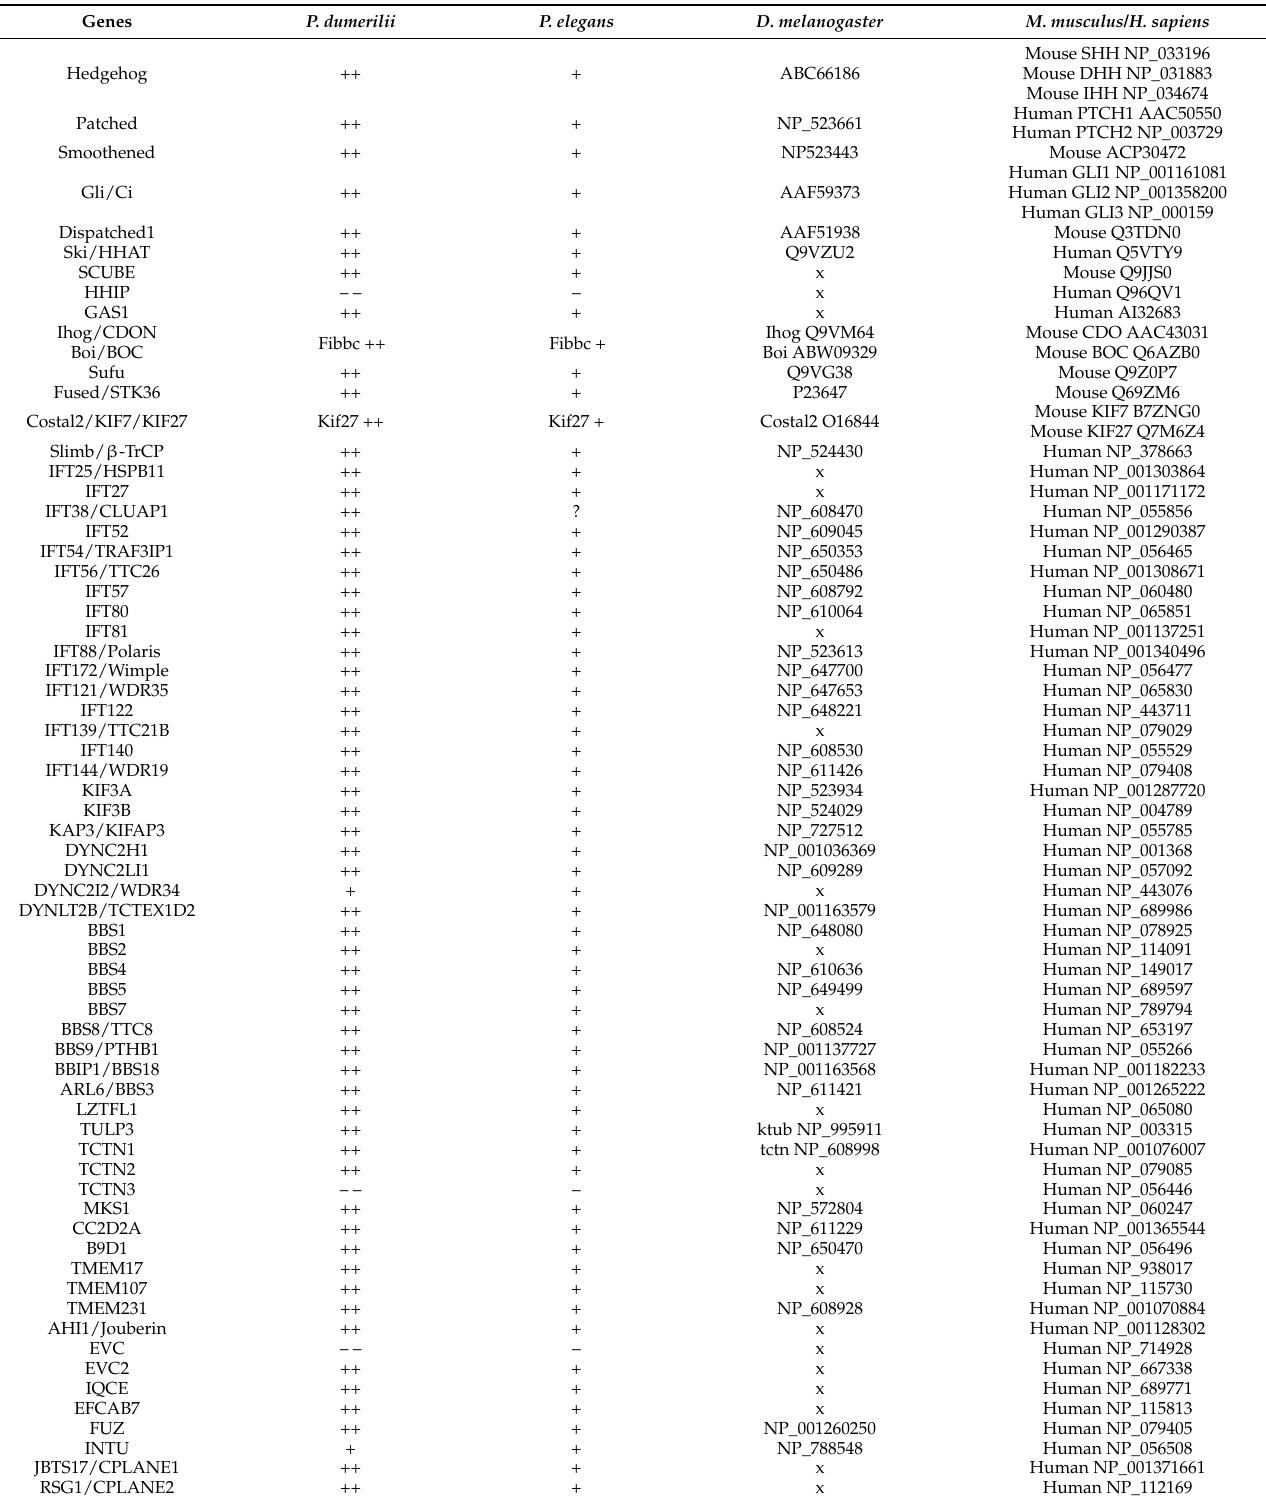
Table 1. Distribution of Hh signaling components in annelids P. dumerilii and P. elegans (this study), Drosophila , and mouse/human. Note that Drosophila lacks 26 genes known to participate in vertebrate Hh signaling. +, found in the transcriptome; ++, found both in the transcriptome and genome; –, not found in the transcriptome; – –, not found in the transcriptome or genome; ?, not found only in the P. elegans transcriptome; x, not found for this species. For Drosophila and mouse/human, amino acid sequence accession numbers are shown, including sequences used in alignments and phylogenetic